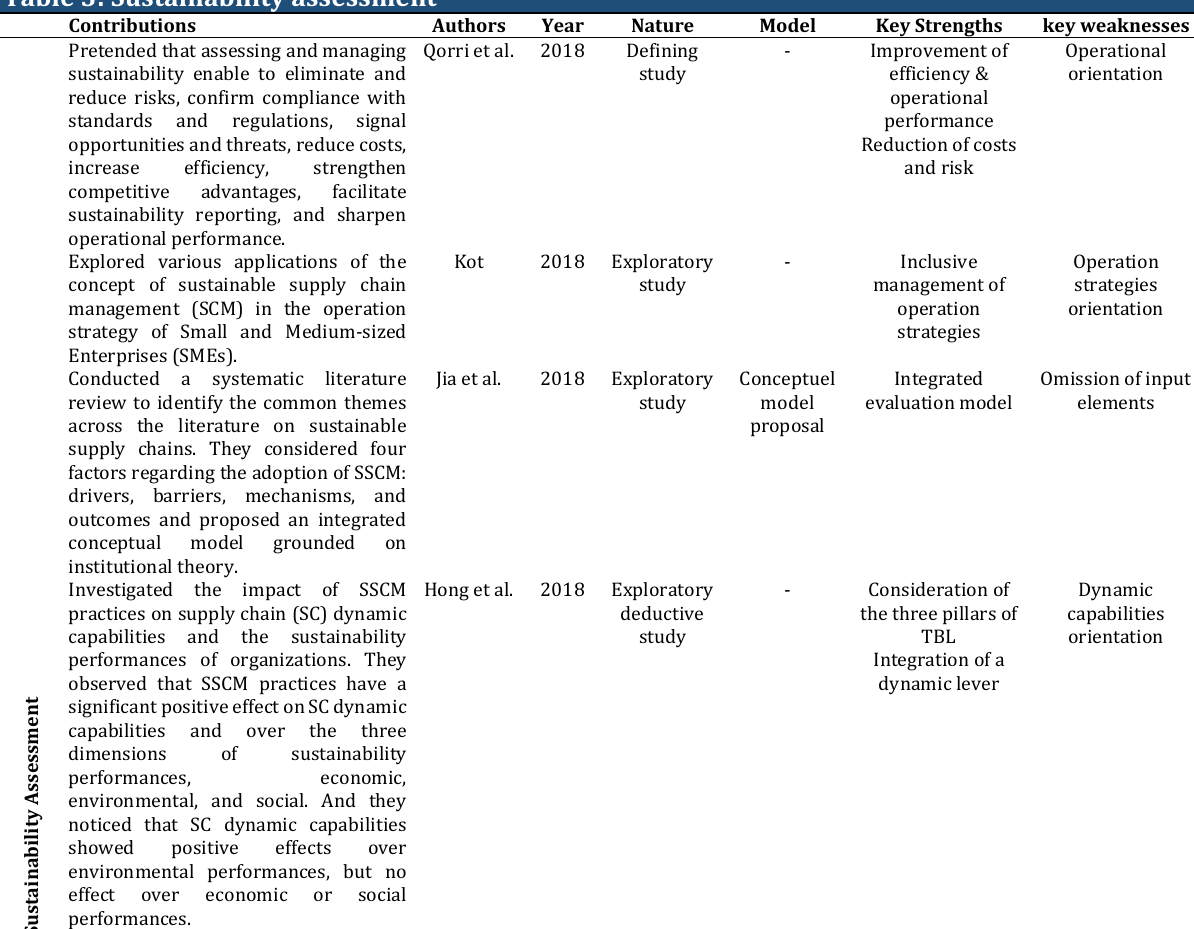
Table 3: Sustainability